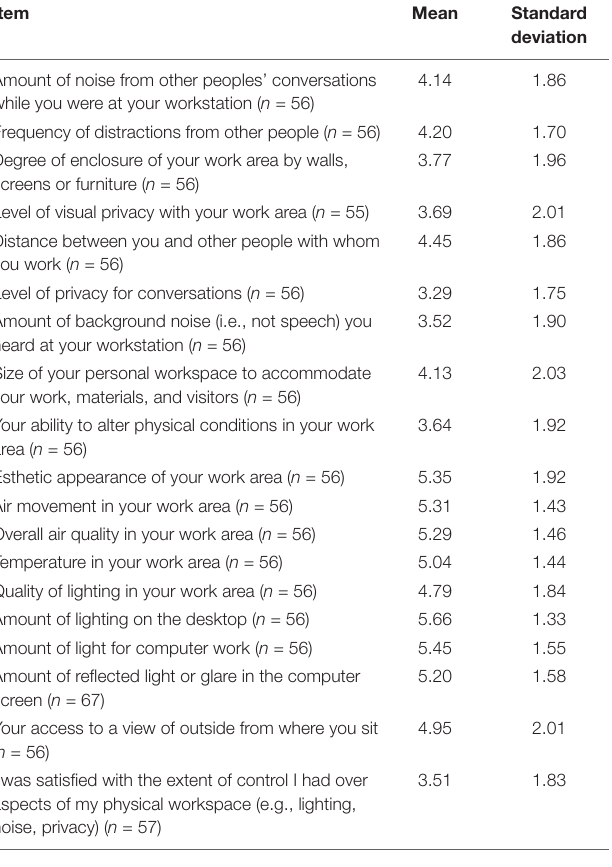
TABLE 3 | Descriptive statistics for items measuring occupant satisfaction with their environment at work before renovation (Time 1). Item Mean